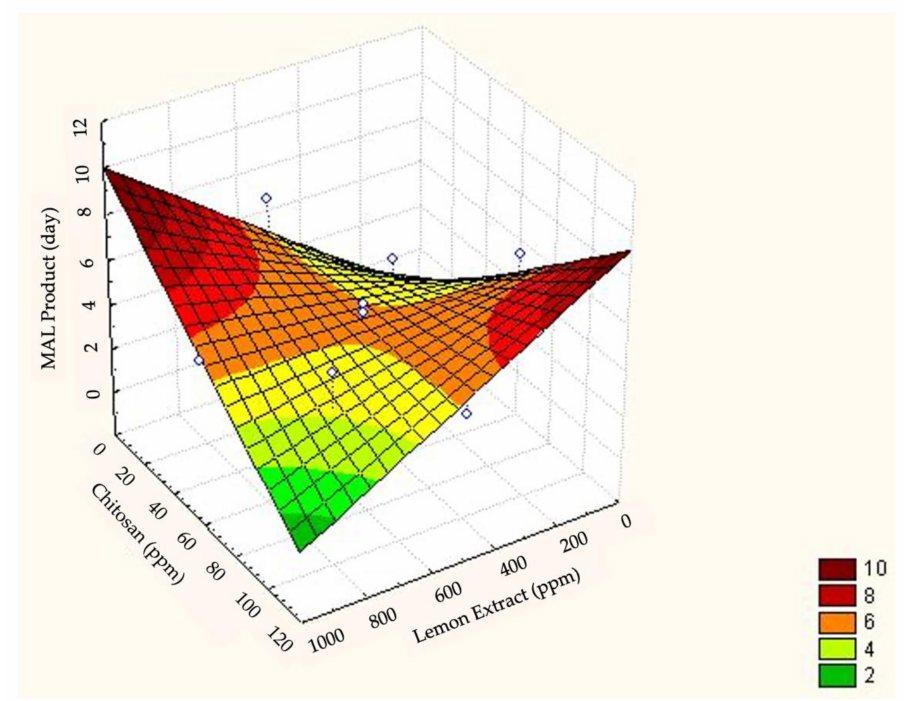
Figure 5. Effects of the interaction between lemon extract and chitosan on the microbial acceptability limit P-MAL (day) of Giuncata